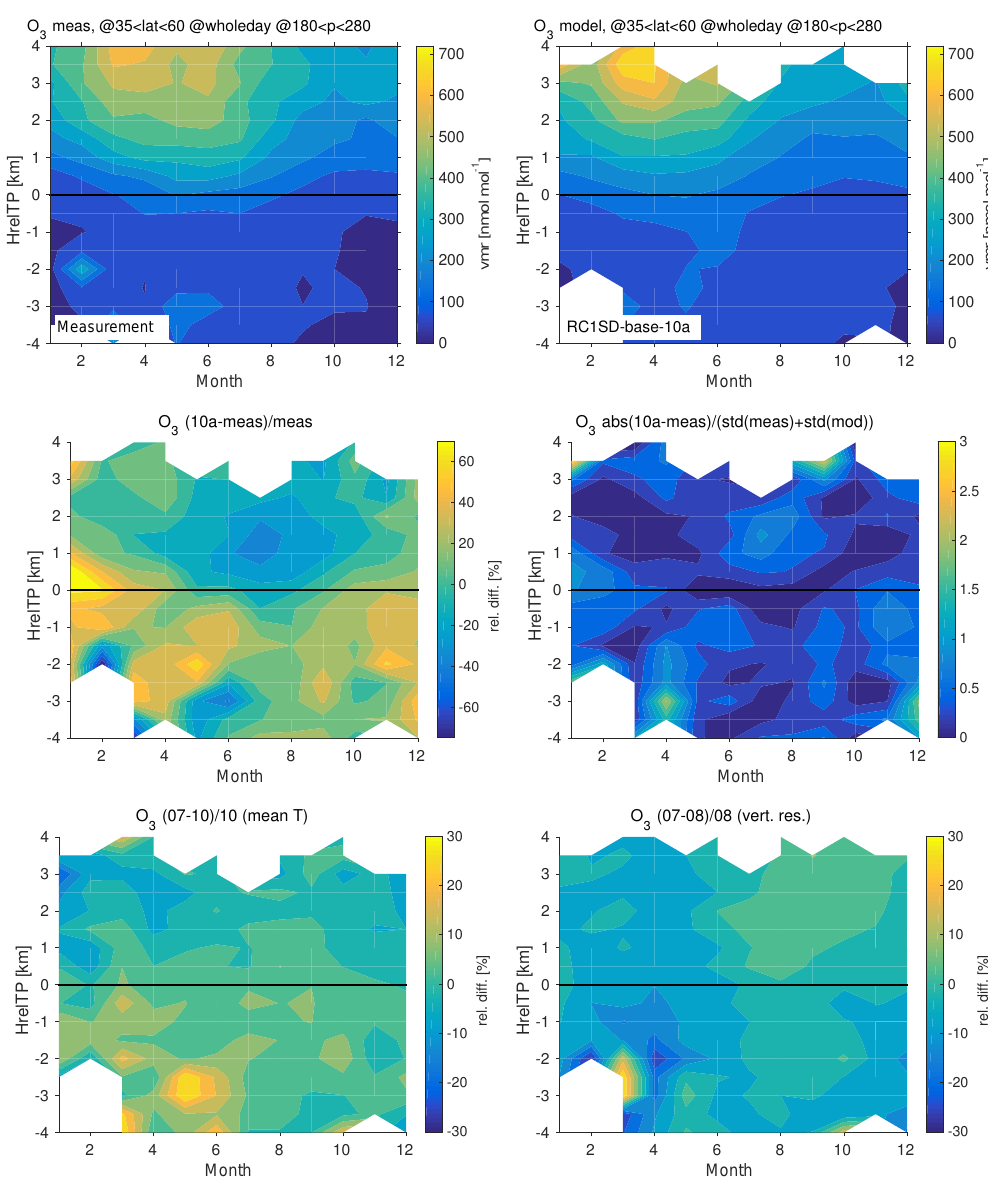
Figure 19. Comparison of O 3 climatologies (35–60 ◦ N) based on data from the years 2005–2013. The first row shows climatologies of CARIBIC measurements (left) and RC1SD-base-10a model data (right). The second row shows the relative differences of model data and measurements (left), and the absolute values of model minus measurements over the sum of the standard deviation of measurements and model (right). The bottom row shows the relative differences of RC1SD-base-07 and RC1SD-base-10, differing in nudging of global mean temperatures (left), and the relative differences of RC1SD-base-07 and RC1SD-base-08, with different vertical resolutions (right). The vertical axis shows the distance (in km) relative to the